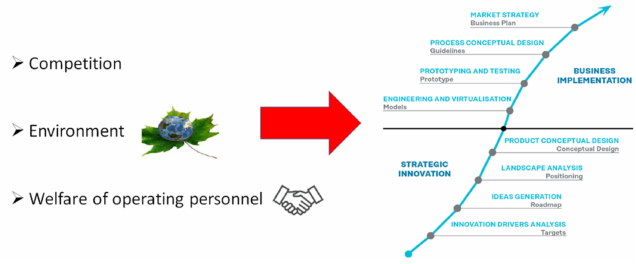
Figure 1. Circular Economy for a cleaner